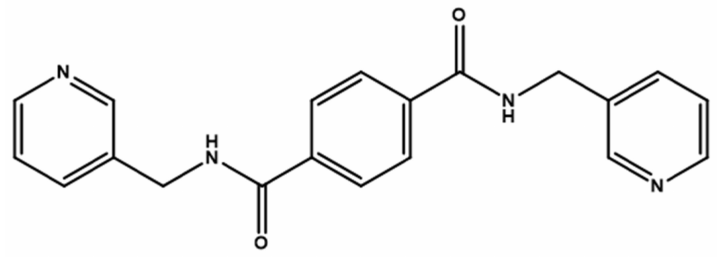
Figure 1. Structure of L